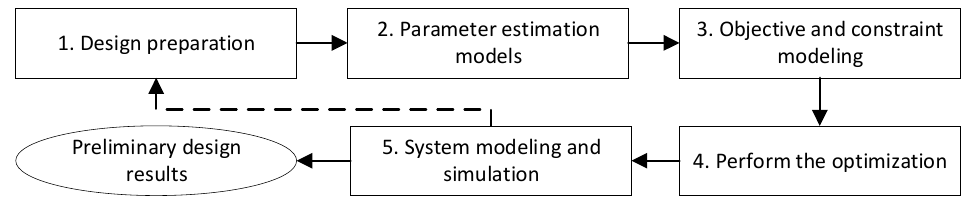
Figure 1. The preliminary design process of high-power EHAs [28].